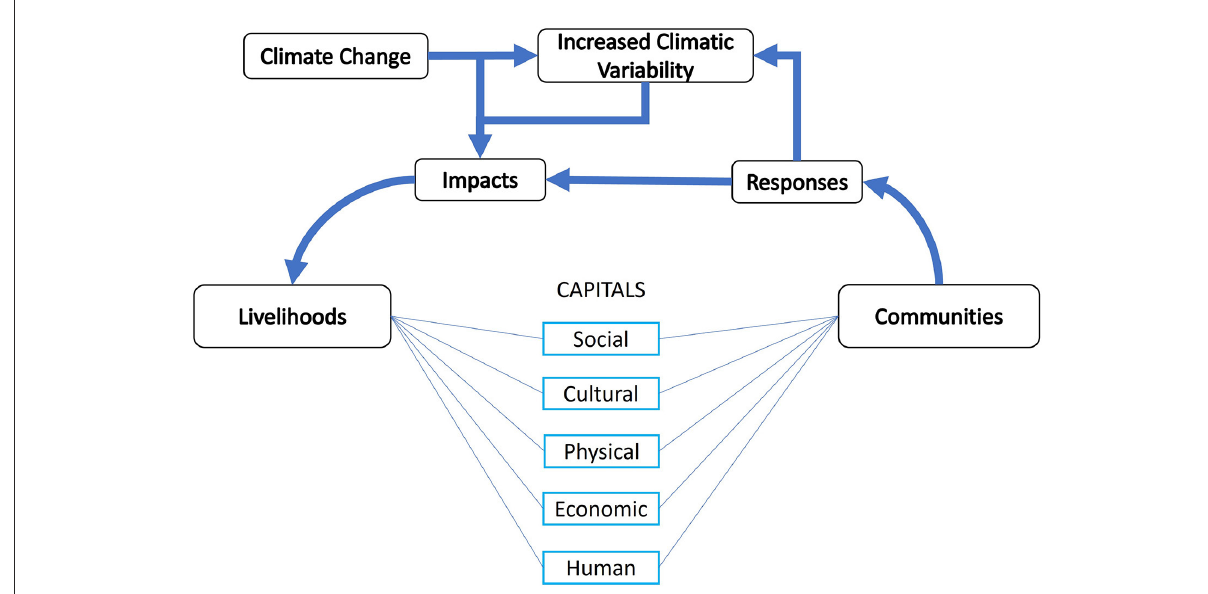
FIGURE1 The explanatory framework of livelihoods and capitals in the context of climate variability. Dark blue arrows indicate that climate change increases climate variability, its impacts on community livelihoods, and response actions. To respond to the impacts the community uses the five capitals that are in the center of the figure connected with light blue